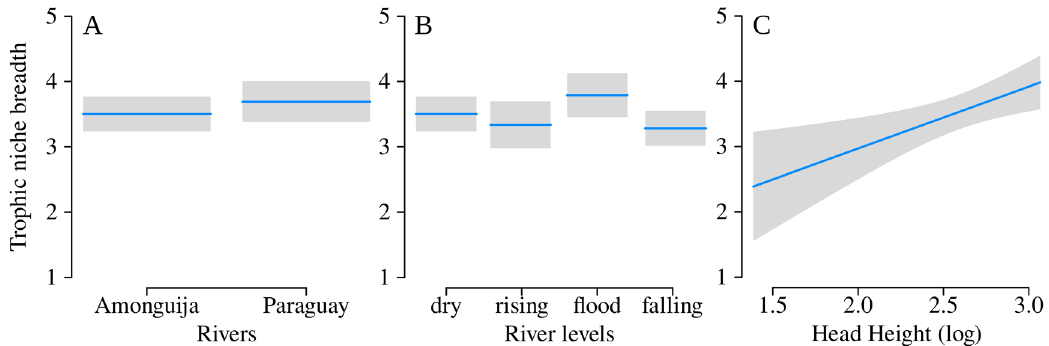
Figure 6. Trophic niche breadth for Eigenmannia desantanai . A) Amonguijá and Paraguay Rivers, B) Hydrological periods and C) Head height, at Porto Murtinho, MS, southern Pantanal,